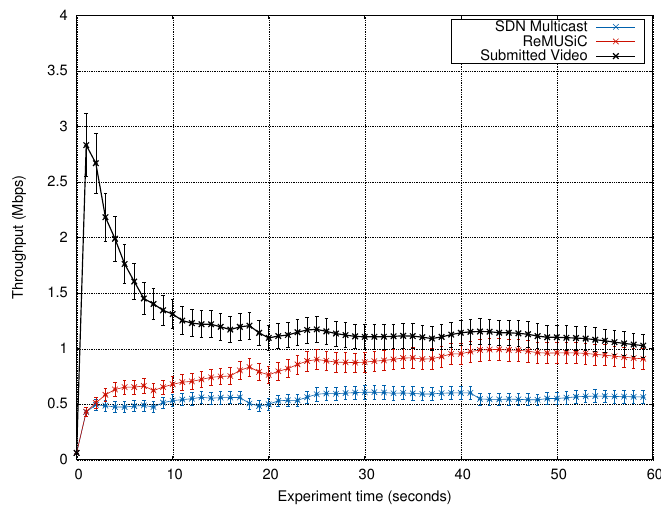
Figure 14. Throughput impact in both ReMUSiC and SDN Multicast experiments.